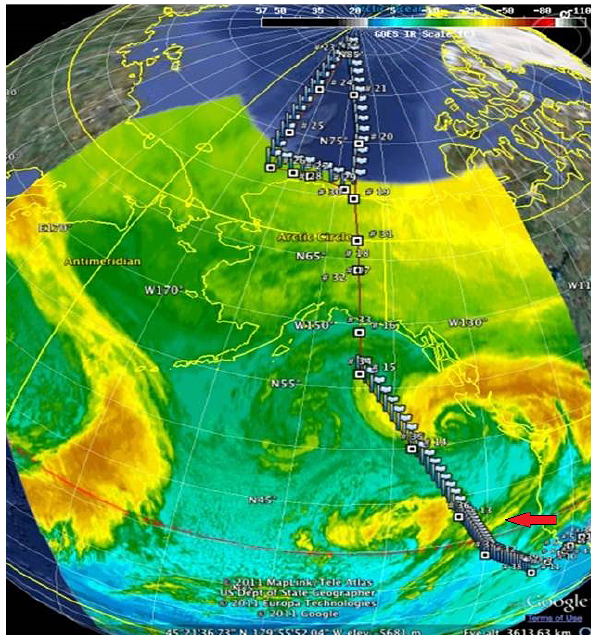
Figure 2. Global Hawk flight track overlaid on the GOES-11 (Geostationary Operational Environment Satellite) IR image for 9 March 2011. The atmospheric river (AR) feature is indicated by the red arrow.